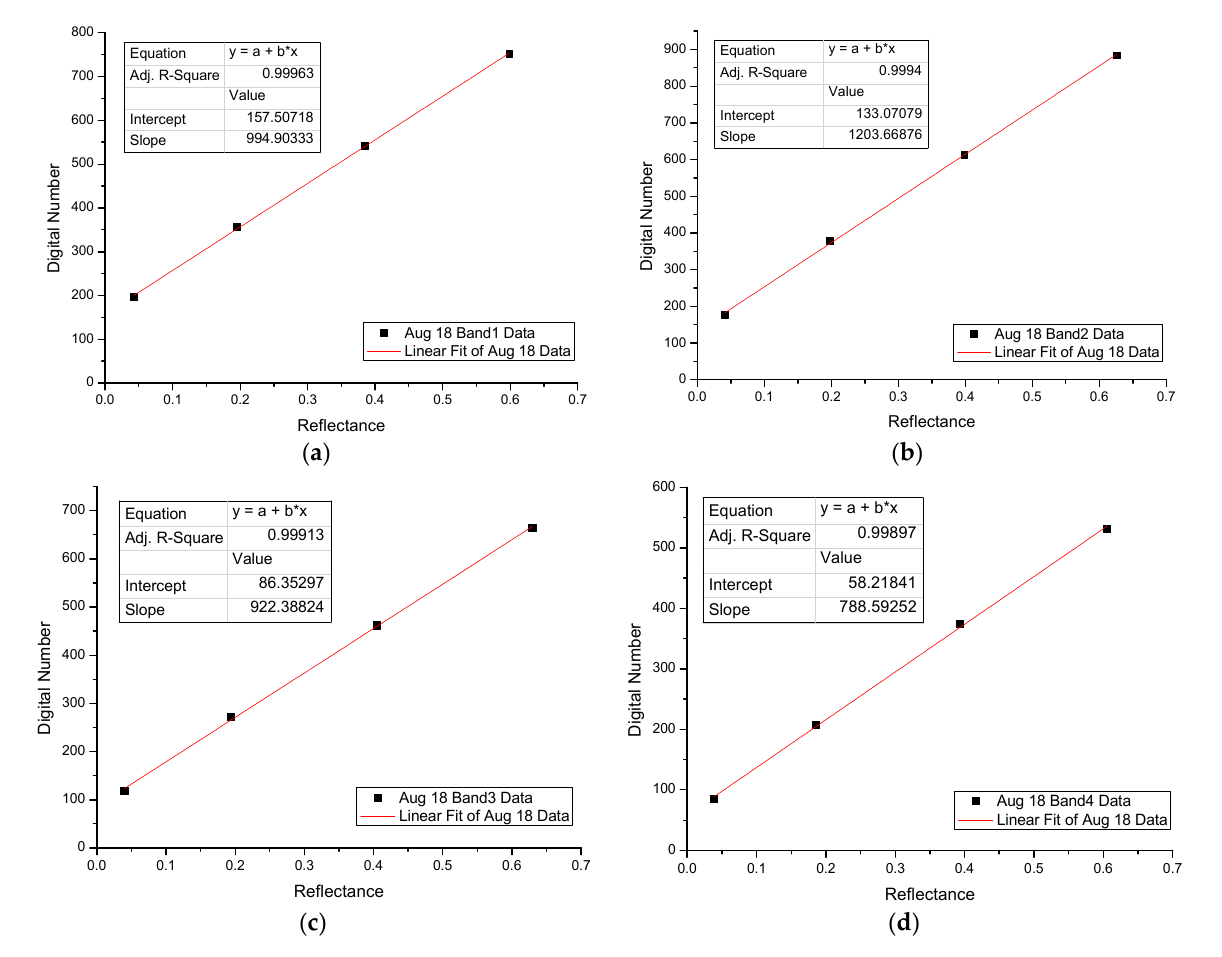
Figure 7. Linear regression curve between the measured ground reflectance of the multi-grayscale targets, and the corresponding image digital numbers on 18 August 2018; ( a – d ) show blue, green, red, and NIR bands.